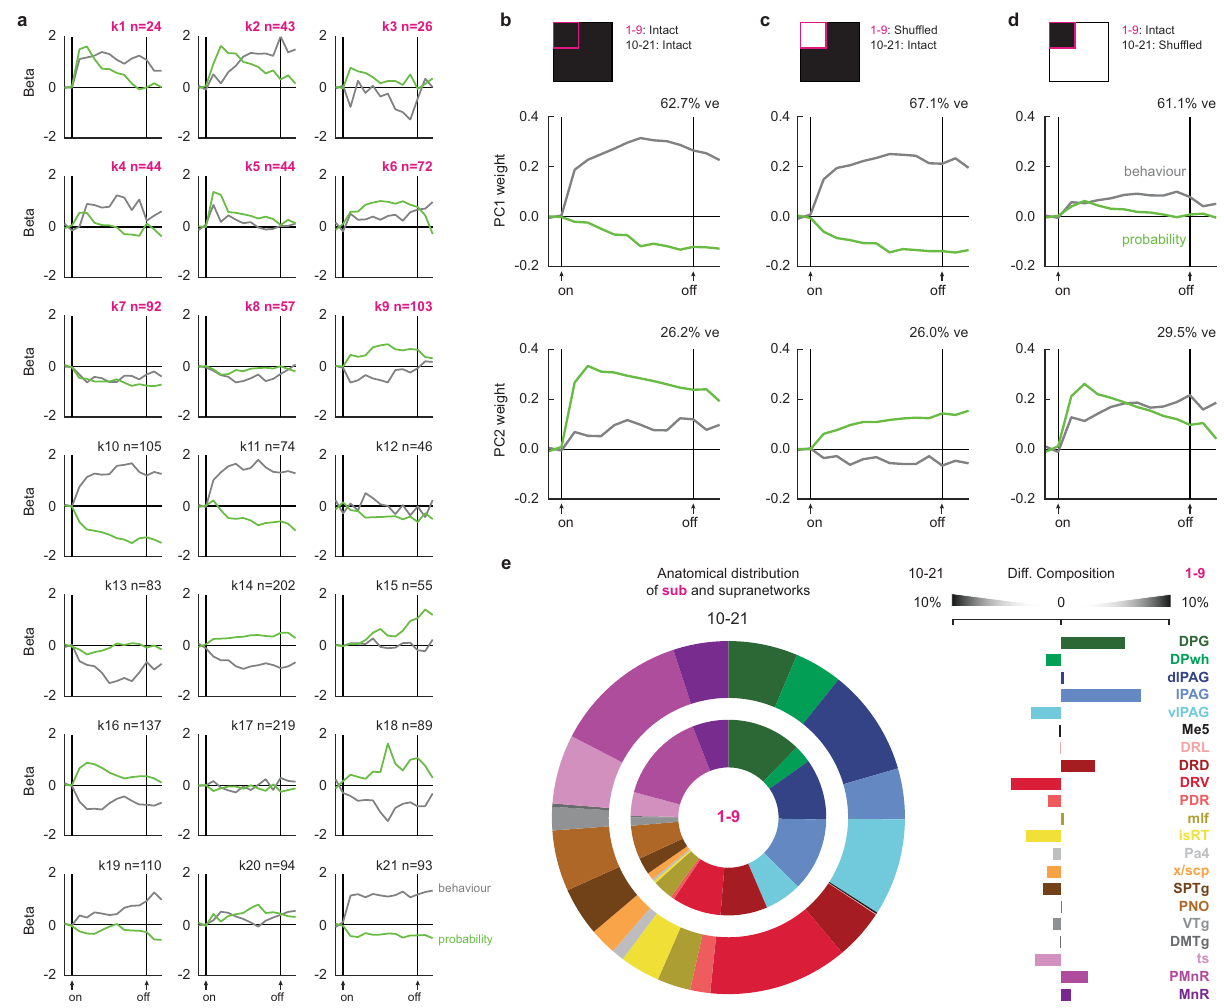
Fig. 3 | Brainstem threat probability and behavior signaling. a Mean cluster (k1 – k21) beta weights for threat probability and behavior over cue presentation (cluster n shown in the fi gure). b Principal components for cluster beta weights (top;datafrom a ),resultingPC1(middle),andPC2(bottom).Dataarepresentedas mean values±SEM. c Principal components for cluster beta weights with cue subnetwork shuf fl ed (top; data from a ), resulting PC1 (middle), and PC2 (bottom).